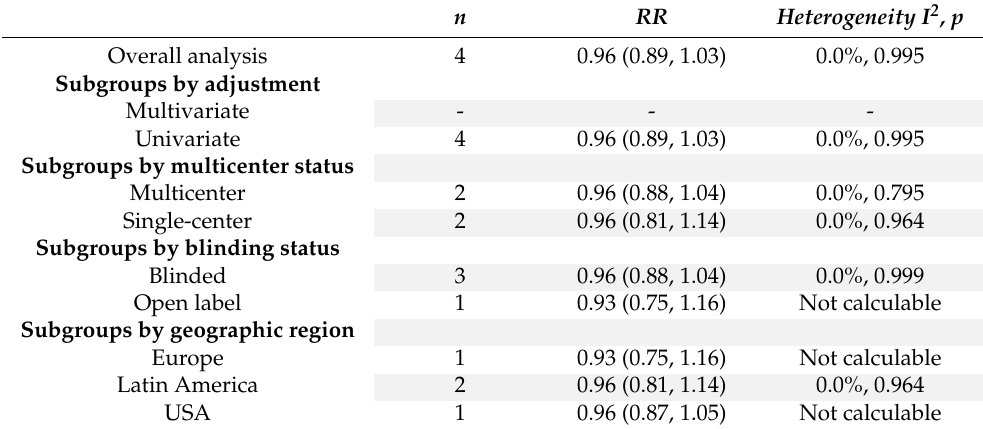
Table 9. Results of the meta-analyses examining the association between convalescent plasma therapy and hospital discharge (14-day); subgroup analyses by adjustment, multicenter status, blinding status and geographic region are presented.